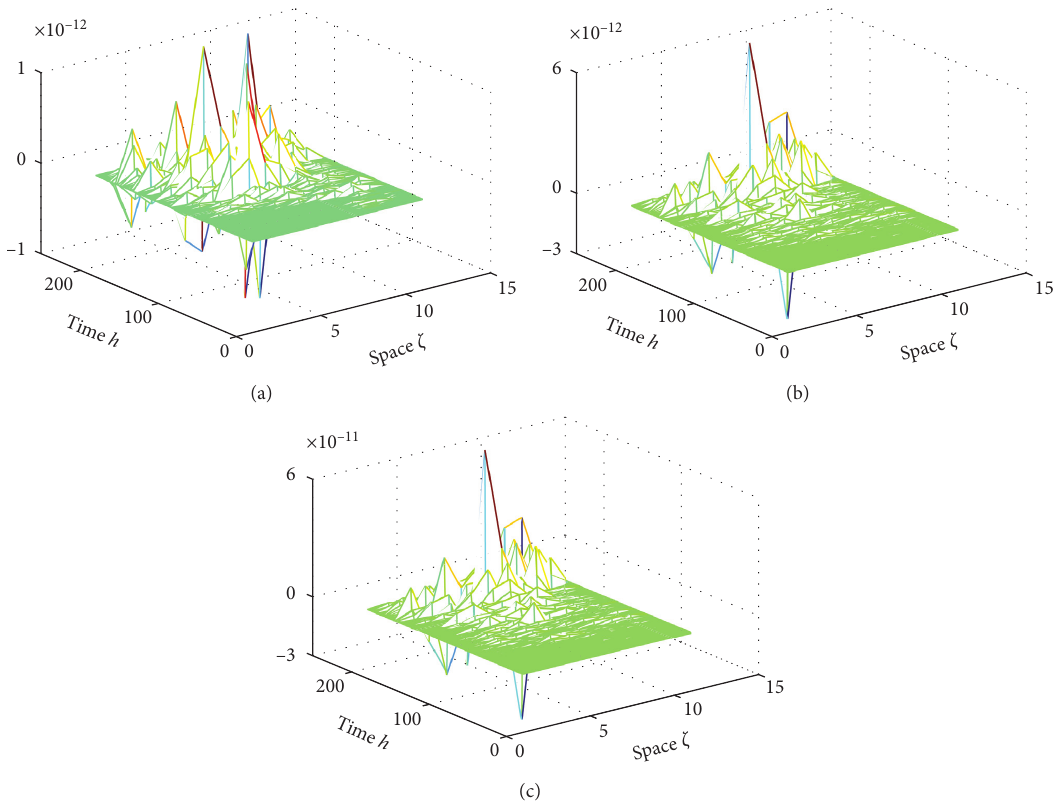
Figure 2: Error surface between the three agents and the virtual leader agent in nonlinear hyperbolic partial MASs. (a) Agent1 error surface